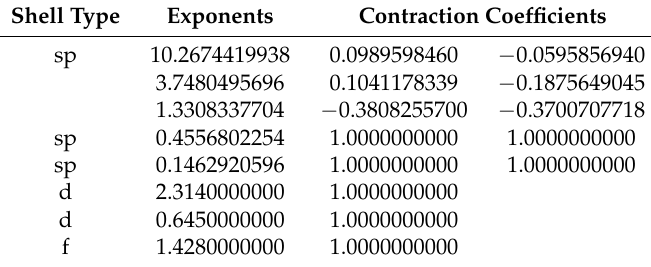
Table A11. Parameters of the cc-TZVP basis set of Oxygen. Parameters taken from [80].